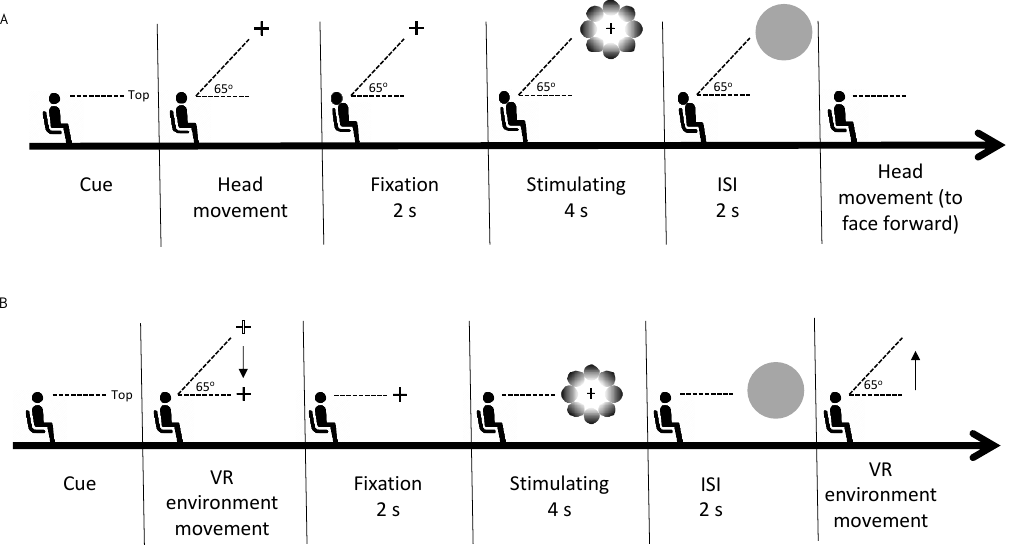
Figure 2. Experimental procedure. ( A ) The phase sequence of one trial in the active scene. Each trial started with the presentation of a textual cue for the direction of the stimulus, following which the observer moved their head in the indicated direction. Next, the observer fixated on the fixation cross for 2 s (fixation phase). Thereafter, a random stimulus (glare/halo) was presented for 4 s (stimulus presentation phase), during which the observer had to keep fixating on the fixation cross without blinking their eyes. Subsequently, the observer was requested to keep their head stable during the 2-s presentation of a gray circle (interval phase). In the last phase, the observer moved their head back to the original position to face forward. ( B ) In the passive scene, the procedure of one trial was the same as in the active scene, except that the observer was not allowed to move their head. After the directional cue was presented, the VR environment automatically moved in the indicated direction. In the last phase, the VR environment moved back to its original location to substitute the head movement to face forward. The automated VR environment movement occurred by playing the coordinates of prerecorded head